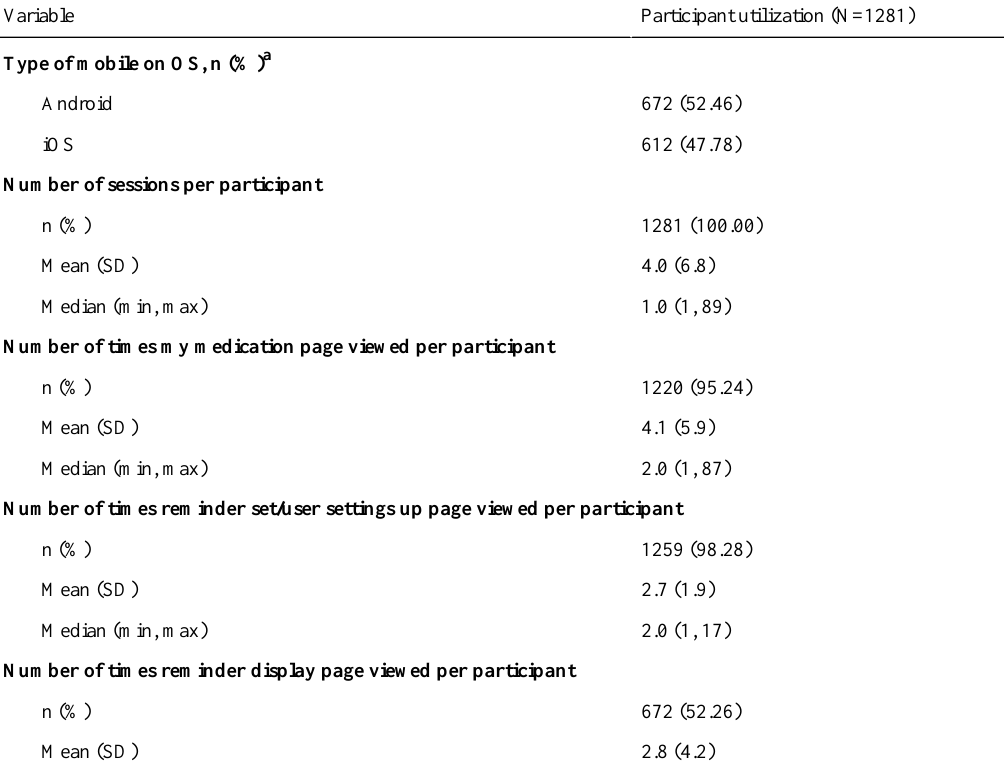
Table 1. Frequency of use metrics of the Pfizer Meds app. iOS: iPhone Operating System; OS: operating